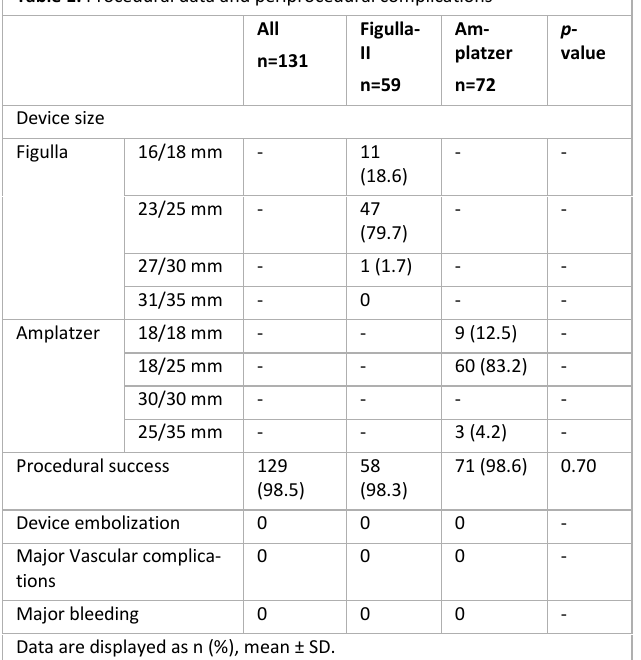
Data are displayed as n (%), mean ± SD.